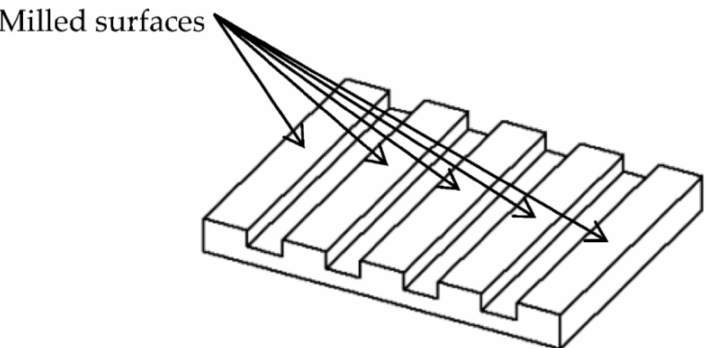
Figure 1. Isometric view of the